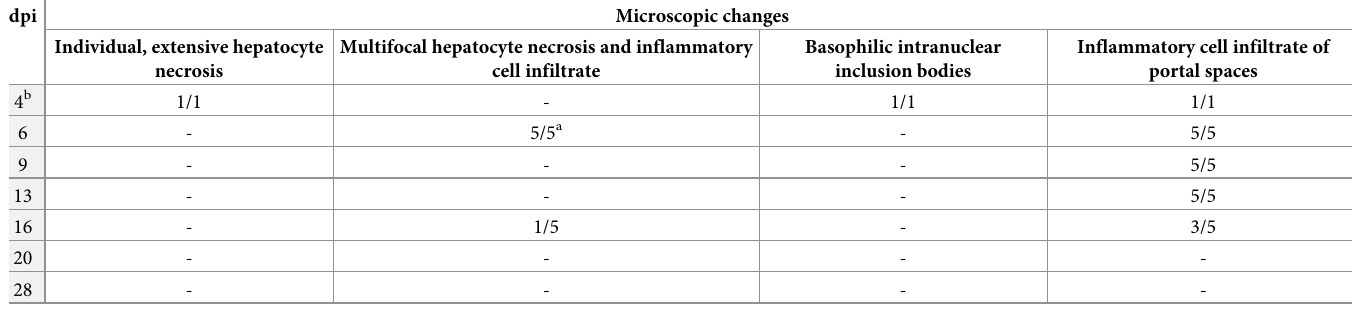
Table 2. Levels of microscopic change occurrence in livers of chickens inoculated with FAdV (MOR300315 strain) from 4 to 28 days post-challenge. dpi